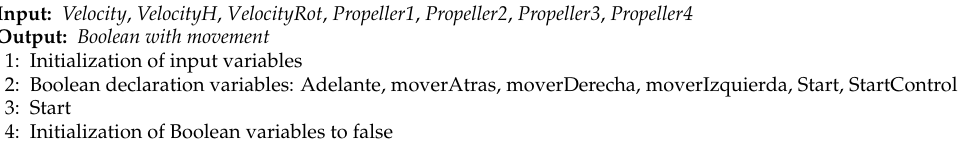
Algorithm 1 Initialization of variables for the drone movement.